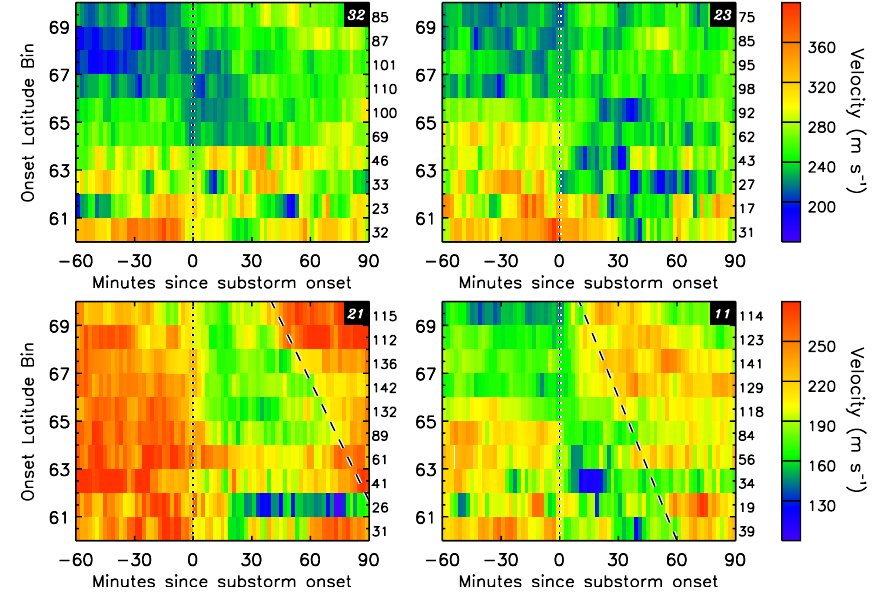
Fig. 5. Nightside ionospheric flow speeds derived from the results of the Map Potential analysis, plotted as a function of time relative to substorm onset for the ten onset-latitude bins. The locations of the flow measurements are indicated by the numbers in the upper right-hand corner of each panel, which are defined in Fig. 2. On the right-hand side of each panel, the mean number of substorms that contributed to the statistics for each onset-latitude bin is shown. The flow magnitudes are indicated by the colour bars on the right-hand side of the figure, with panels common to a row sharing the same scale. The vertical dotted lines indicate the time of substorm onset in the superposed-epoch; the dashed lines are described in the